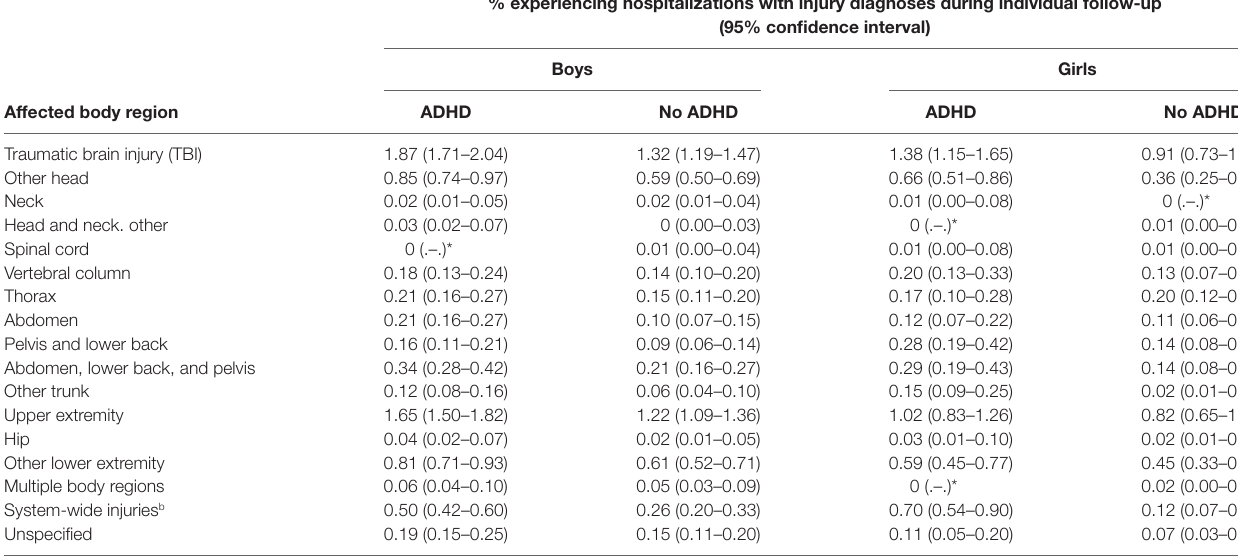
TaBle 2 | Estimated % experiencing hospitalizations with injury diagnoses during follow-up of 36 months, by body region. a